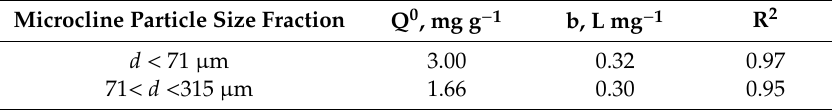
Table 2. The Langmuir isotherm constants of methylene blue on microcline mass containing particles smaller than 71 µ m ( d < 71 µ m) and in the range from 71 µ m up to 315 µ m (71 µ m < d < 315 µ m) in aqueous suspensions in the initial dye concentration range of 10 − 200 mg L − 1 . The temperature was 22.5 ◦ C, the microcline mass concentration was 13.5 g L − 1